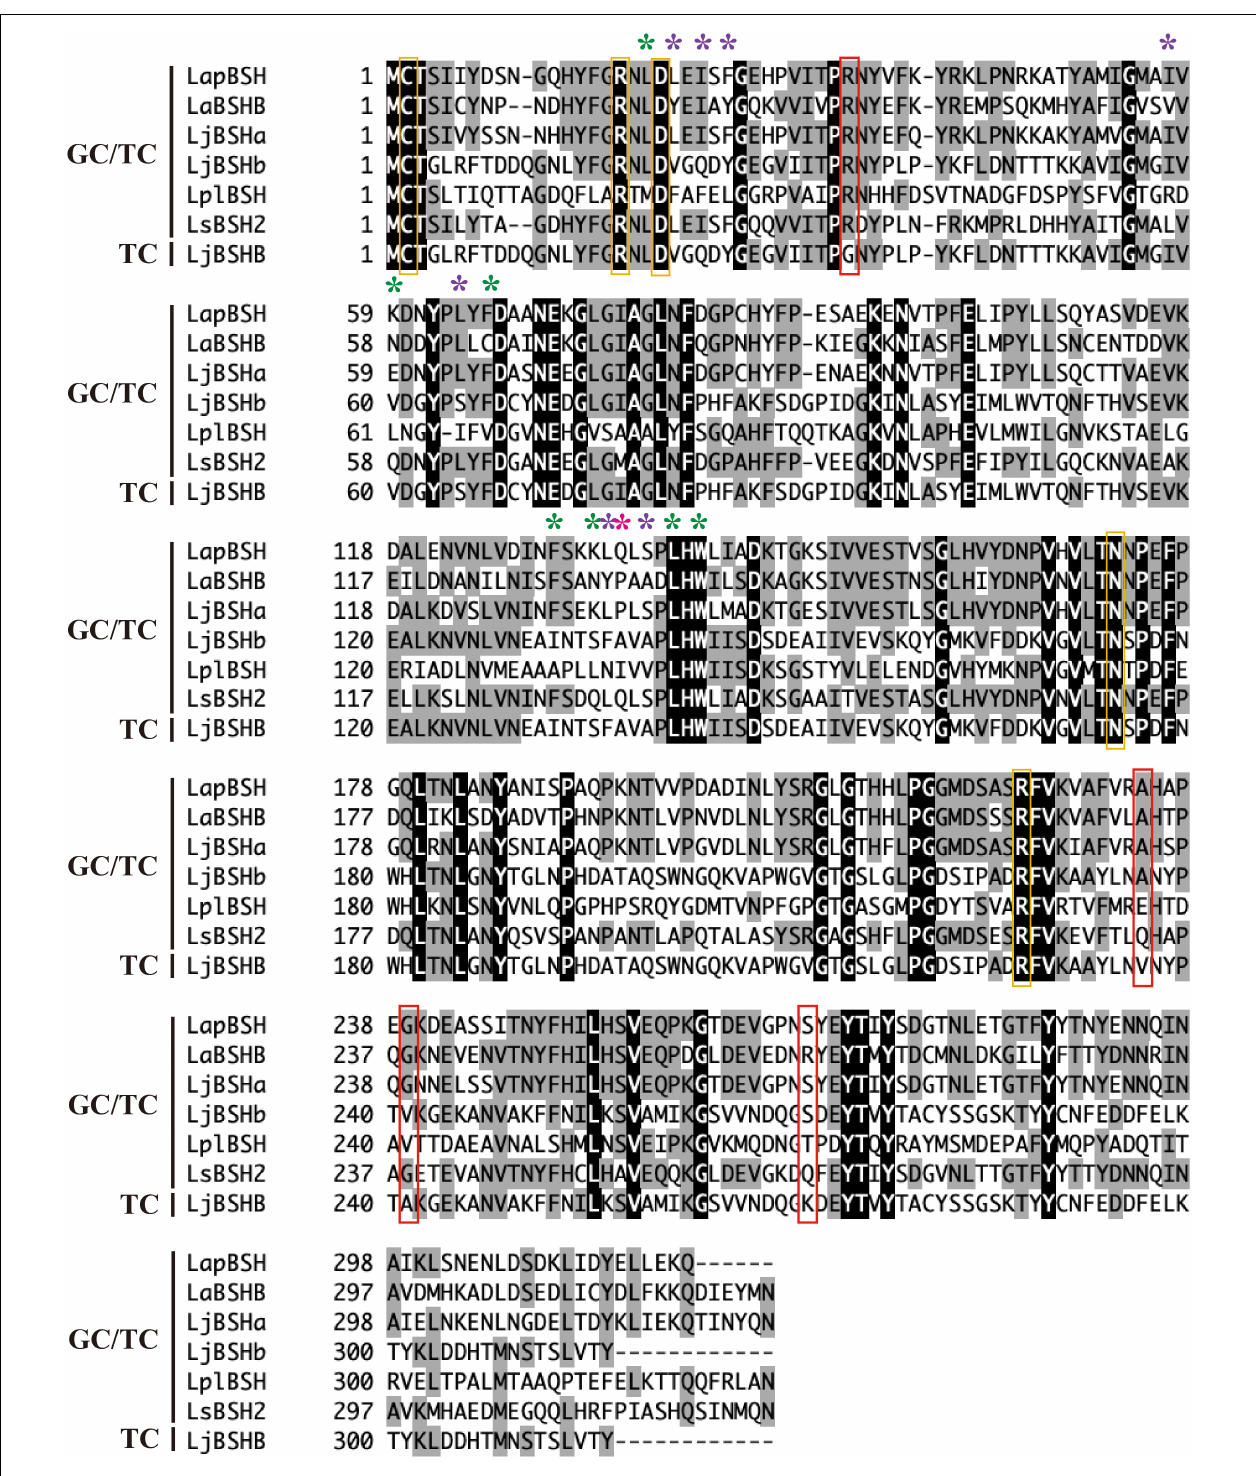
FIGURE 4 | Multiple alignment of the amino acid sequences of LapBSH and other BSHs from Lactobacillus species. The black shading and gray shading represent identical and similar amino acid residues, respectively. The conserved residues (Cys, Arg, Asp, and Asn) associated with the predicted active site are indicated in orange boxes. Amino acid residues involved in the potential substrate specificity of known BSHs (CpBSH, BlBSH, and LgBSH) are indicated by green, purple, and pink asterisks, respectively (Rossocha et al., 2005; Kumar et al., 2006; Rani et al., 2017; Dong and Lee, 2018). Four amino acid residues that are not conserved in LjBSHB (TC) are indicated in red boxes. Abbreviated as follows: LapBSH (BBD48441), LaBSHB (AAV42923), LjBSHa (AAG22541), LjBSHb (AAC34381), LplBSH (AGG13404), LsBSH2 (ACL98205), and LjBSHB (EF536029).